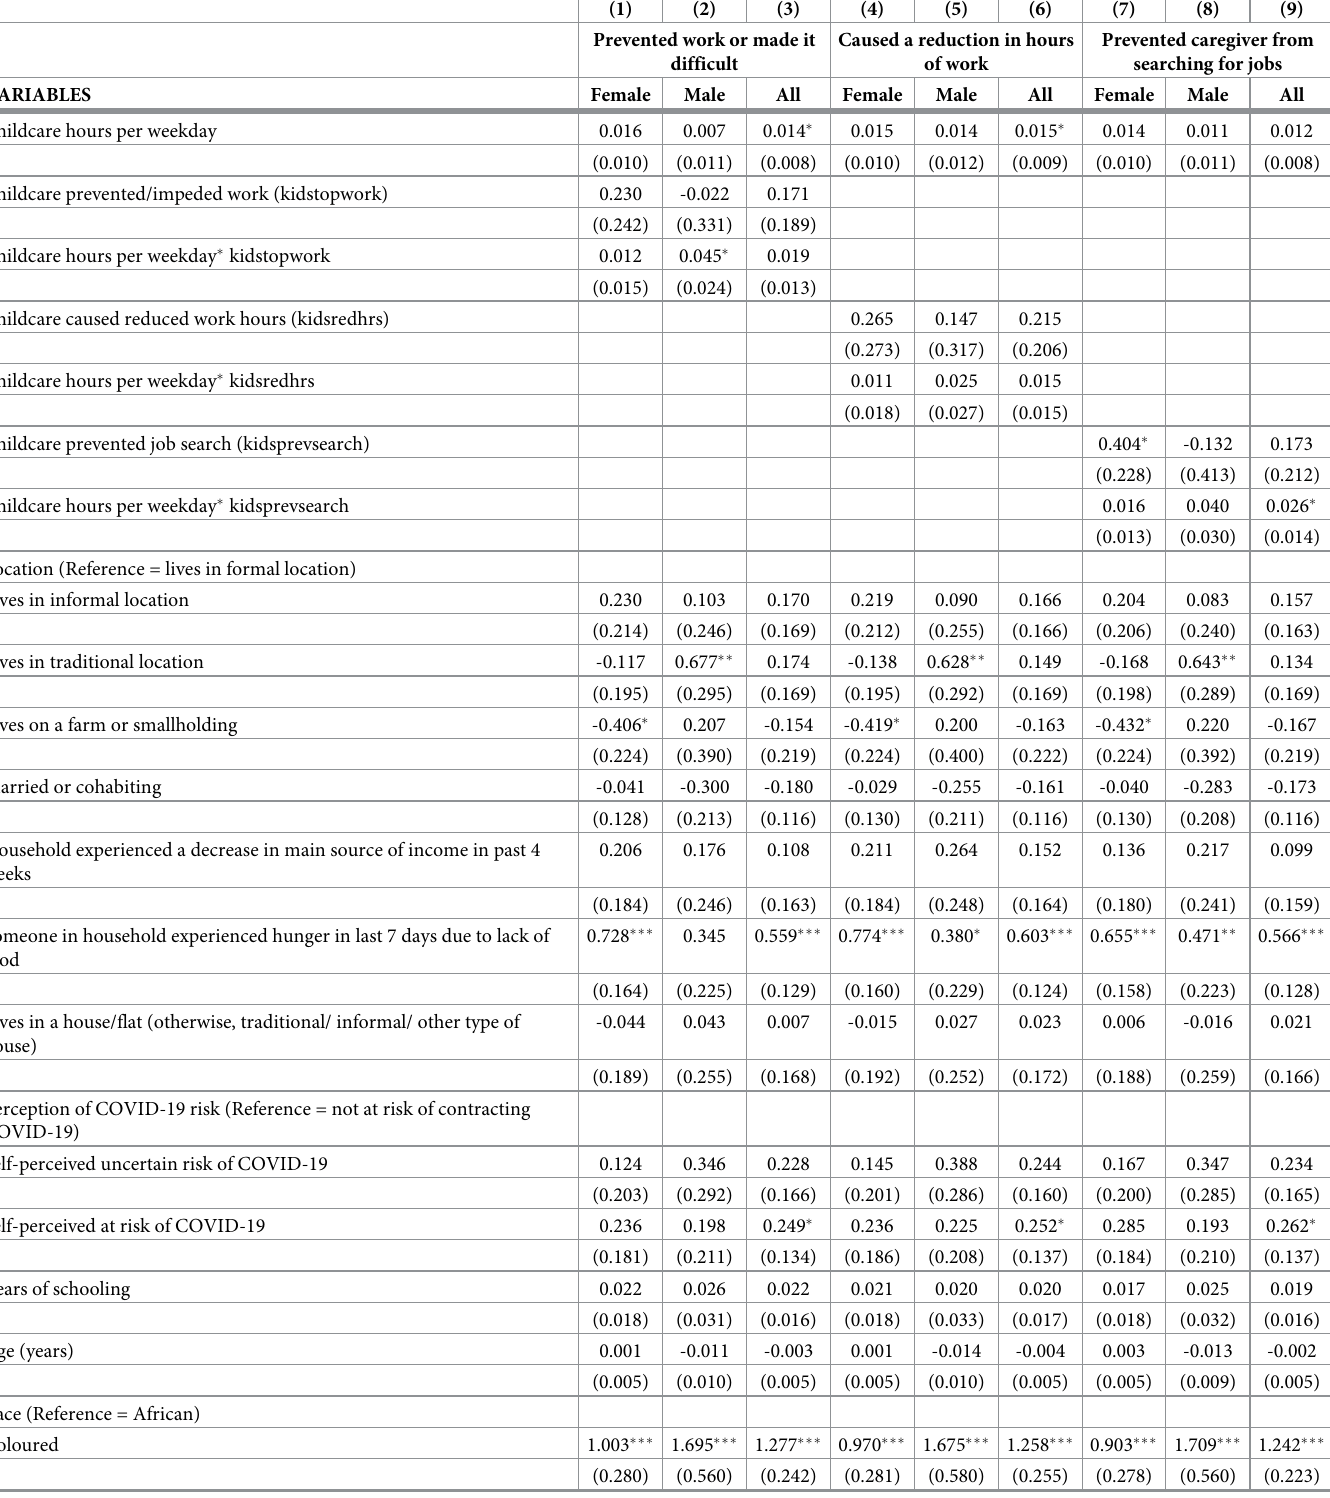
Table 3. Labour market-related factors possibly mediating the relationship between depression and